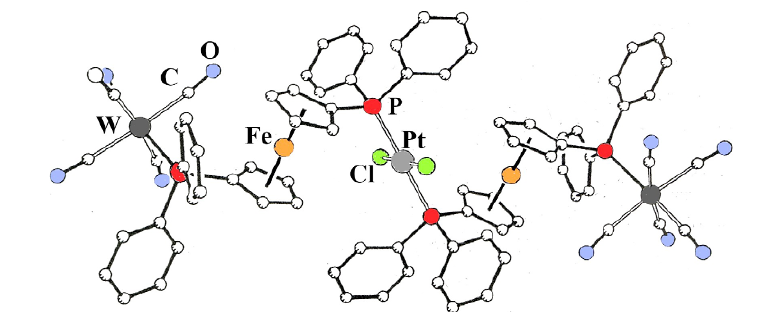
Figure 7. Structure of [{(CO) Table 3. Summary of the mean Pt-M bond and no-bond distances in heteropentanuclear platinum clusters.